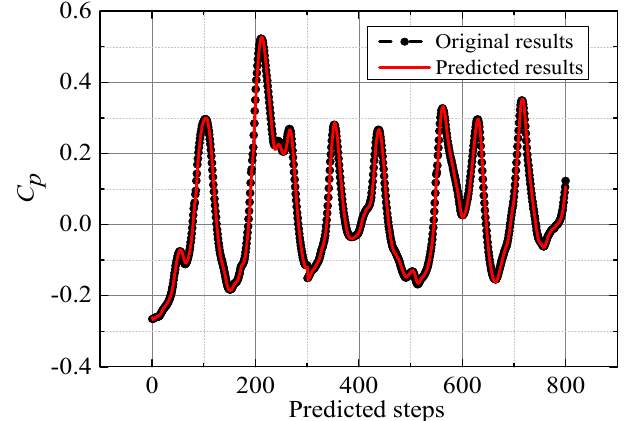
Figure 9. Predicting results of KKF-VSM with three-orders.